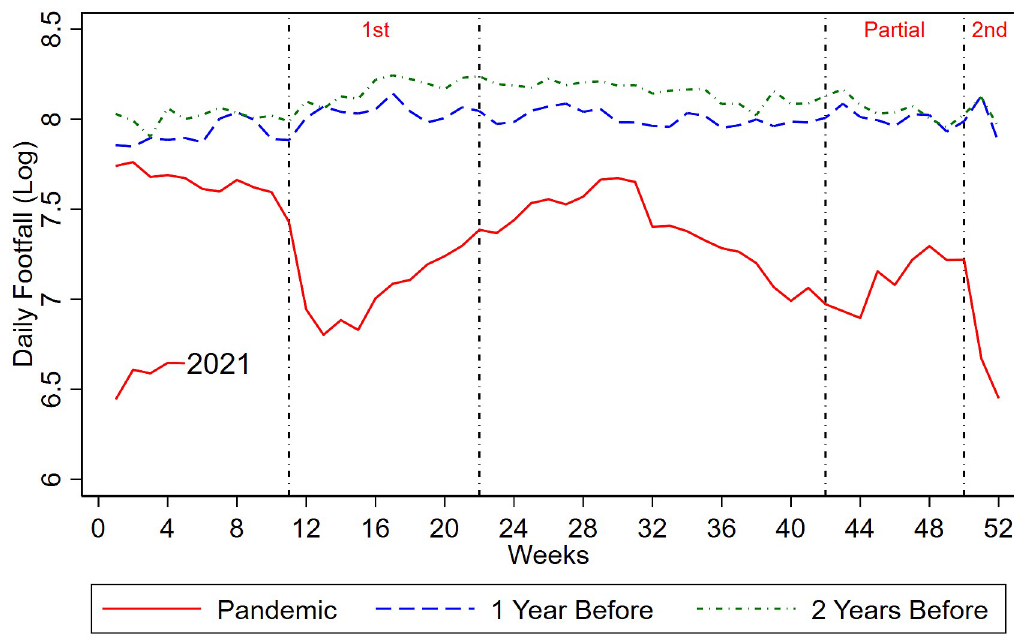
Fig 3. Footfall over time. The log of weekly footfall during first (1 st ) , partial (Partial) and second lockdown (2 nd ) in the year of pandemic, 1 year before and 2 years before.